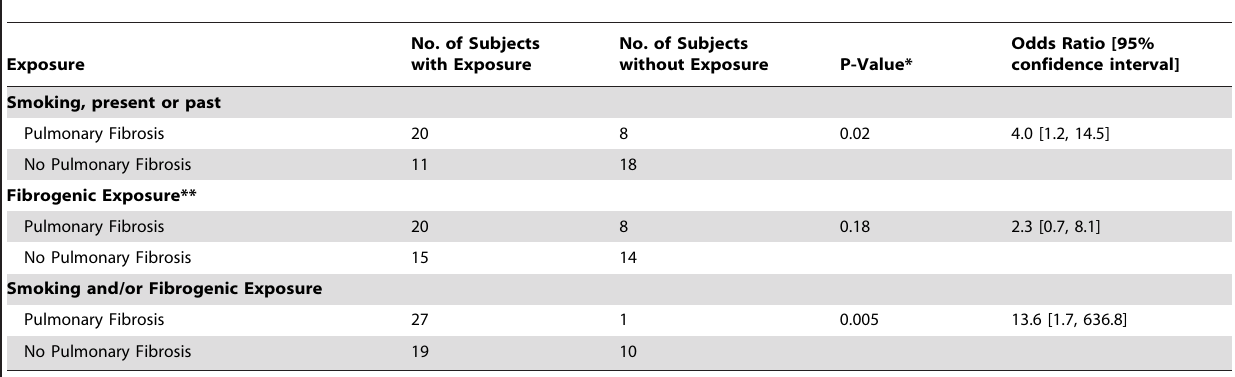
Table 4. Relationship between smoking, fibrogenic exposures and pulmonary fibrosis in TERT mutation carriers $ 40 years of age.